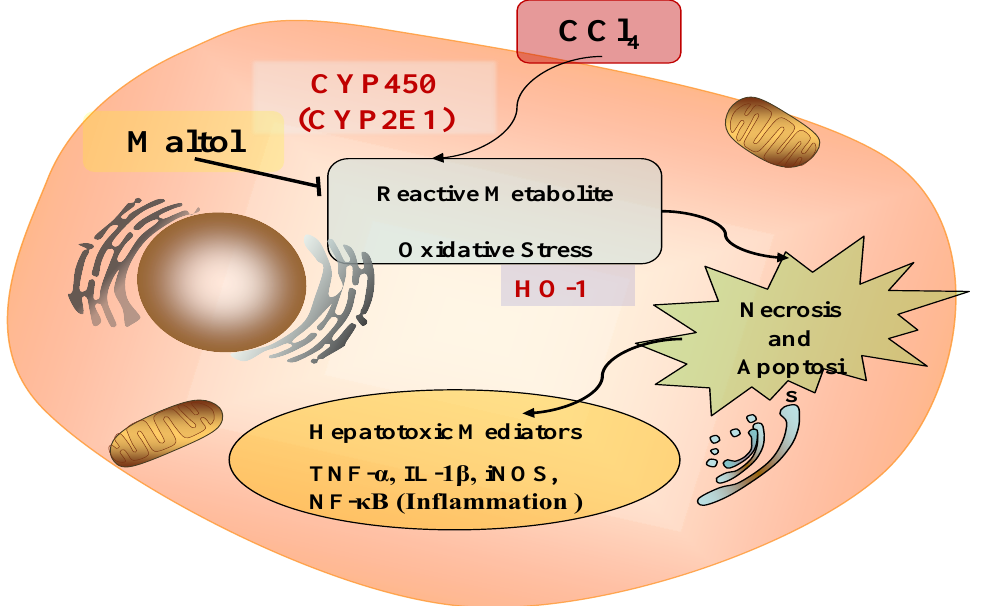
Figure 9. The schematic diagram of mechanism underlying ameliorative effects of maltol against CCl 4 -induced liver injury.